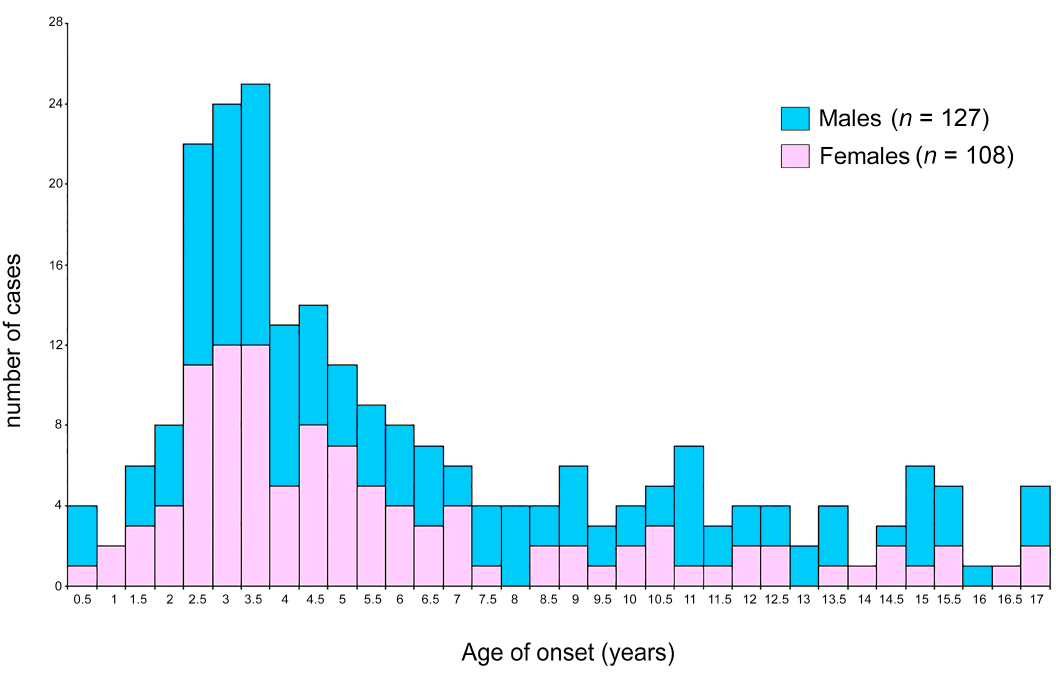
Figure 1. ALL onset age distribution according to sex. Females (pink) and males (light blue) in the whole cohort. whole